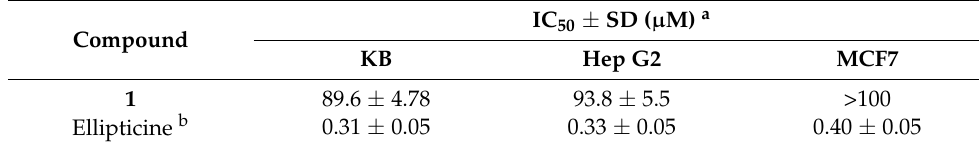
Table 3. Cytotoxic activity of 1 against three human cancer cell